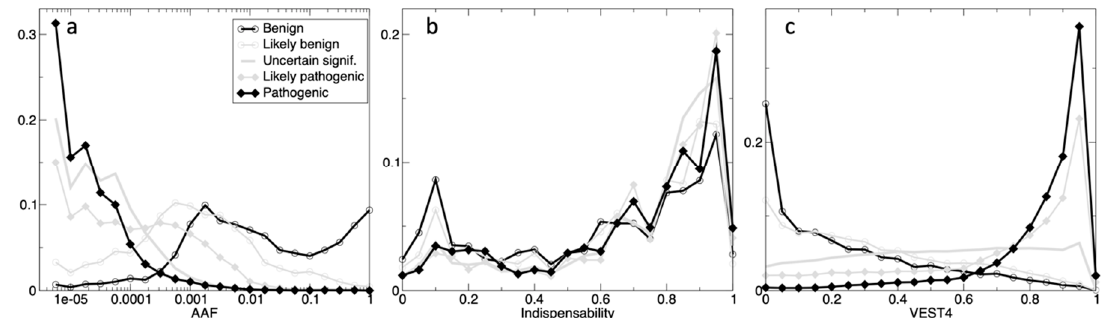
Figure 1. The histograms of the ClinVar’s classes in the dimensions: AAF ( a ), indispensability ( b ) and VEST4 ( c ). The counts are normalized to the total count (in five classes) in 20 bins (range 0-1, step 0.05) for the scores, and 24 bins for AAF (step 0.25 on the log 10 scale). For AAF, the x -axis is on the log 10 -scale, e.g., 10 − 2 means that a variant can be found in 1 every 100 individuals. The five classes are: ‘ Benign ’ (thick open black circles), ‘ Likely_benign ’ (thin open grey circles), ‘ Uncertain_significance ’ (thick grey), ‘ Likely_pathogenic ’ (thin grey closed diamonds), and ‘ Pathogenic ’ (thick closed black diamonds).